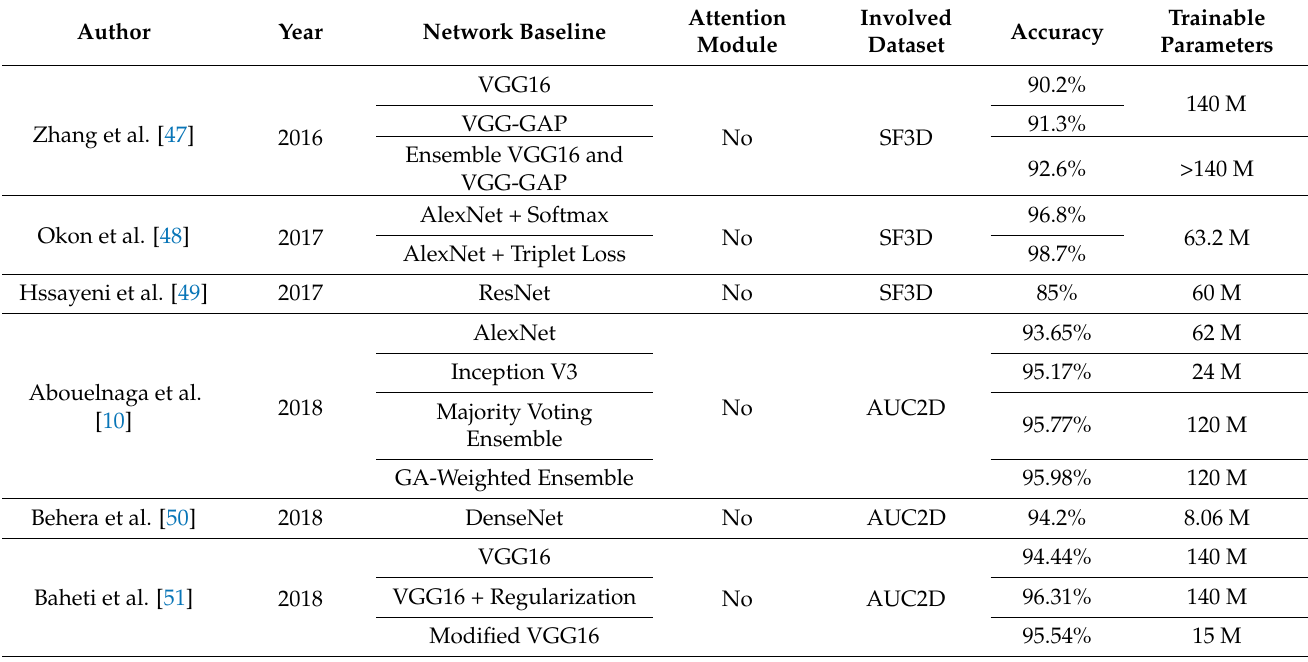
Table 7. A listed comparison of LWANet with other